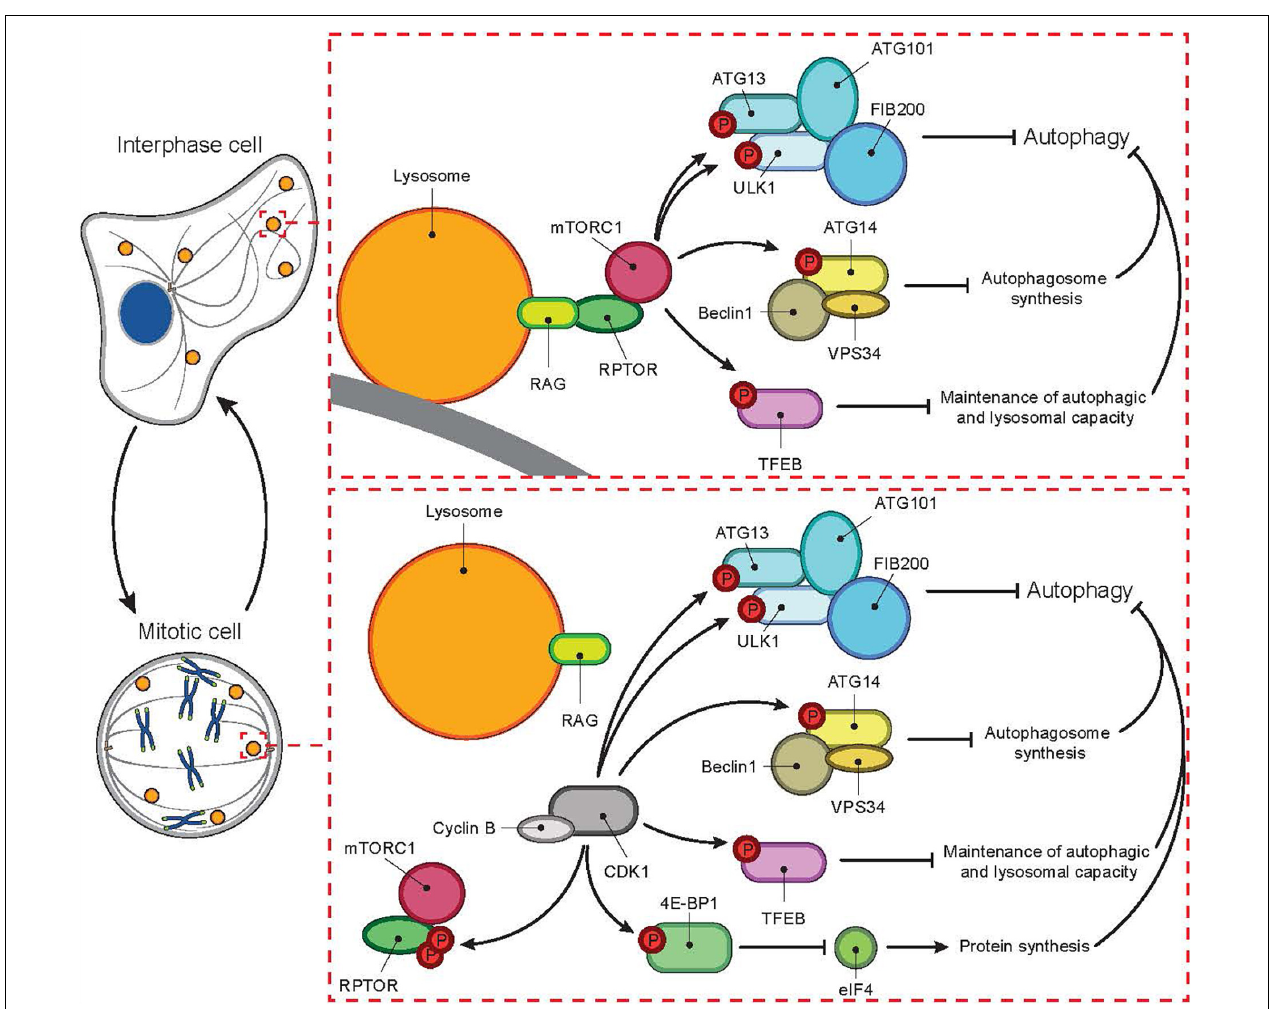
FIGURE 1 | Cell cycle-dependent switch of autophagic master regulator. In interphase, autophagy is tightly controlled by mTORC1. In the absence of nutrients mTORC1 is inactive while autophagy is active. During nutrient-rich conditions, mTORC1 localizes to the lysosomal membrane and gets activated through an interaction between RPTOR and RAG proteins. Activated mTORC1 then inhibits autophagy at several levels, for example by phosphorylating ATG13, ULK1, ATG14, TFEB, and 4E-BPI. In mitosis, mTORC1 activity is inhibited even in the presence of nutrients by CDK1-mediated phosphorylation of RPTOR. In parallel, CDK1 overtakes mTORC1’s role as the inhibitor of autophagy by phosphorylating autophagic mTORC1 substrates listed